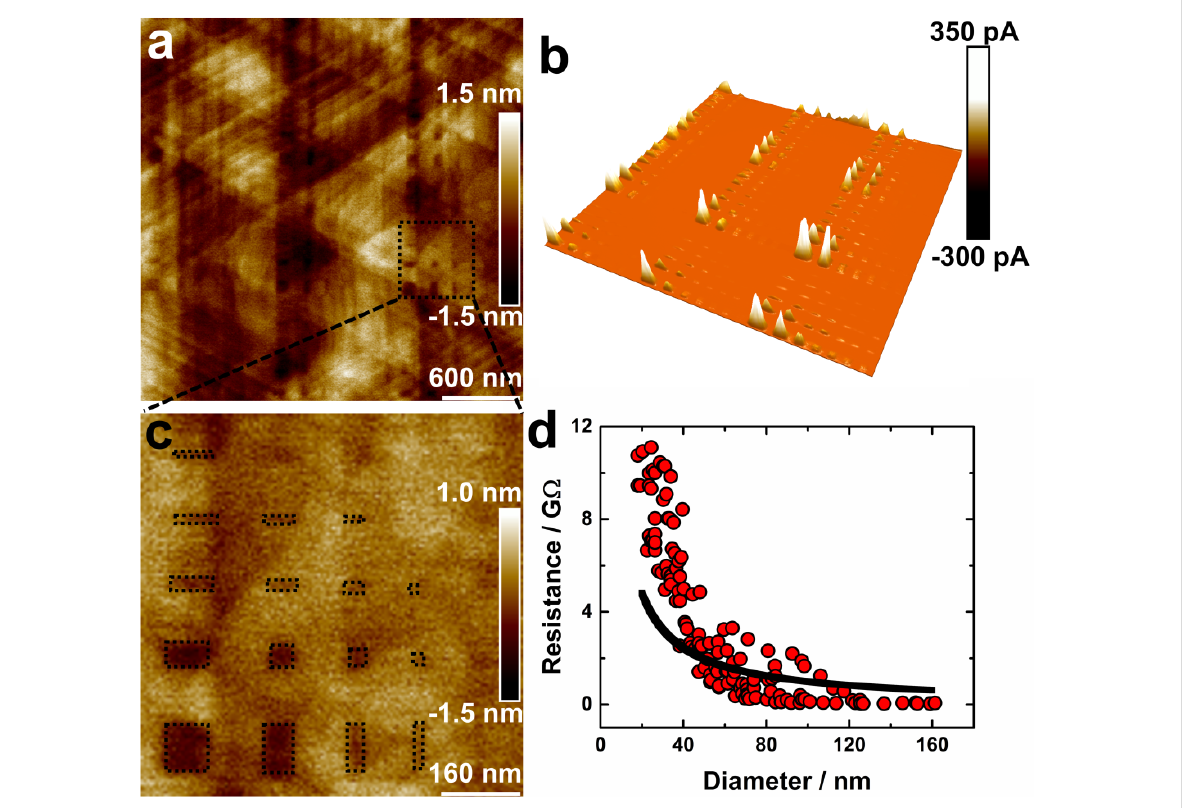
Figure 2: (a) Topography and (b) the corresponding 3D current image (DC bias: 11.1 mV, current sensitivity range: 0–100 pA) of islands obtained from HDT matrix inserted into the PAT SAM. (c) Enlarged topography view of different islands which are marked with a dotted frame shown. (d) Resistances measured for different PAT islands as a function of island diameter. The black line shows the result of a fit in the diameter interval 20–160 nm by using Equation 1.